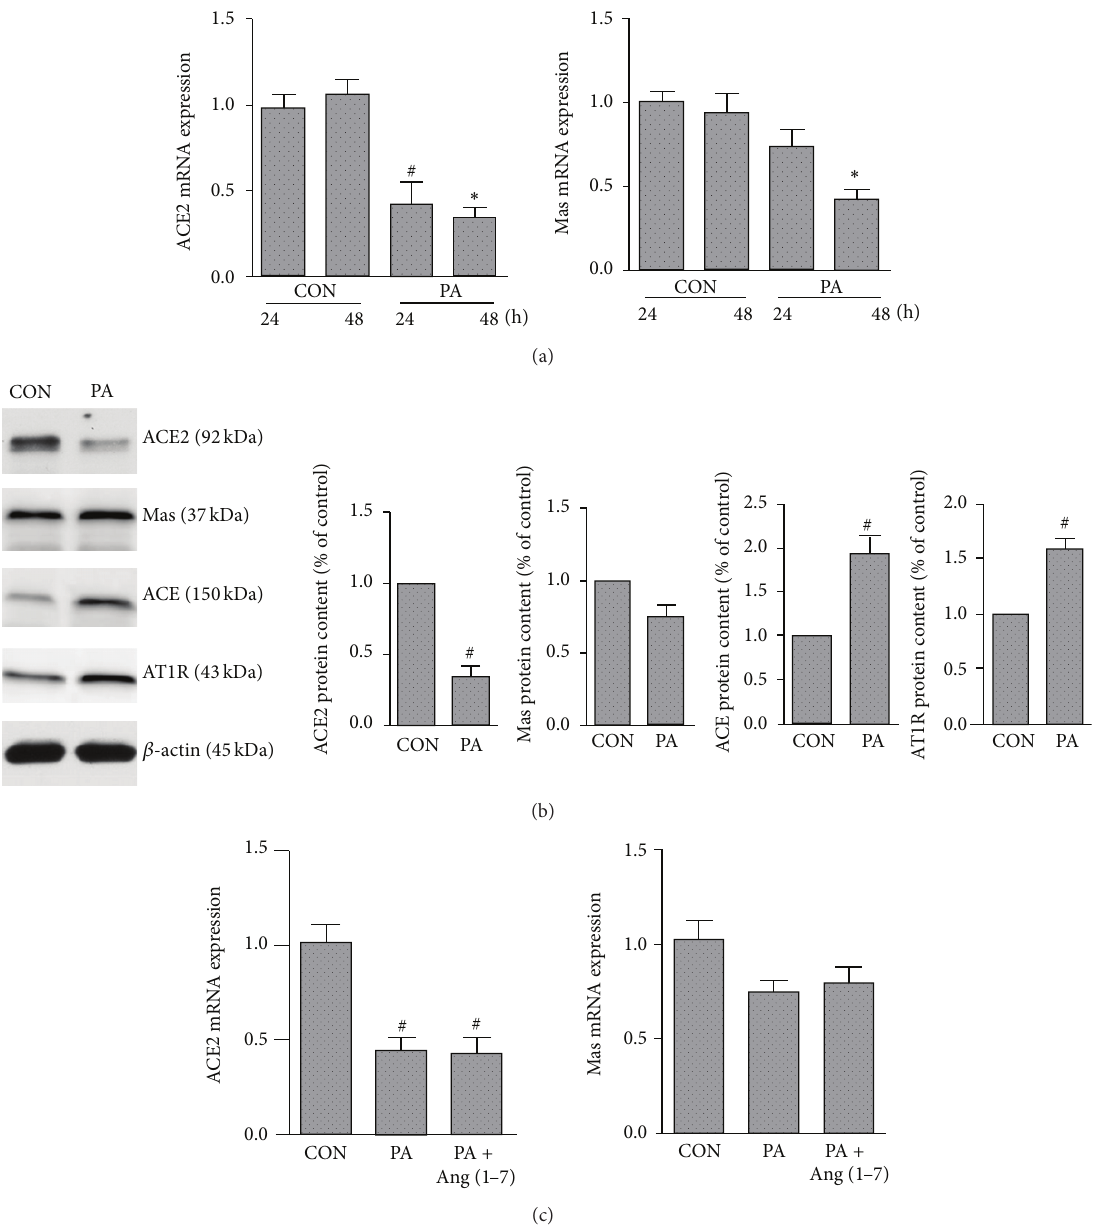
Figure 1: The effects of palmitate on the RAS in cultured MS-1 cells. Cells were incubated for 24 or 48 h with 0.25% BSA (CON) or palmitate (PA, 0.25 mmol/L). ACE2 and Mas receptor mRNA levels were measured (a). Cells were incubated for 24h with palmitate (PA, 0.25 mmol/L), alone or in combination with Ang (1–7) (10 −6 mol/L). Representative western blots showing the protein expression levels of ACE2, Mas, ACE, and AT1R (b). RT-PCR showing the mRNA levels of ACE2 and Mas receptor (c). Values are mean ± SEM, 𝑛 = 4 for each group. # 𝑃 < 0.05 versus CON of 24 h; ∗ 𝑃 < 0.05 versus CON of 48